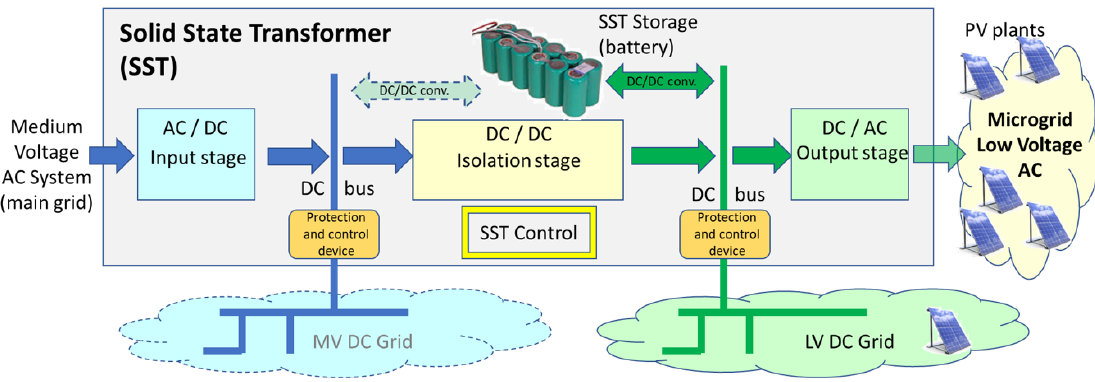
Figure 3. SST with a flexible connection through storage included by design. Example for unidirectional power flow.